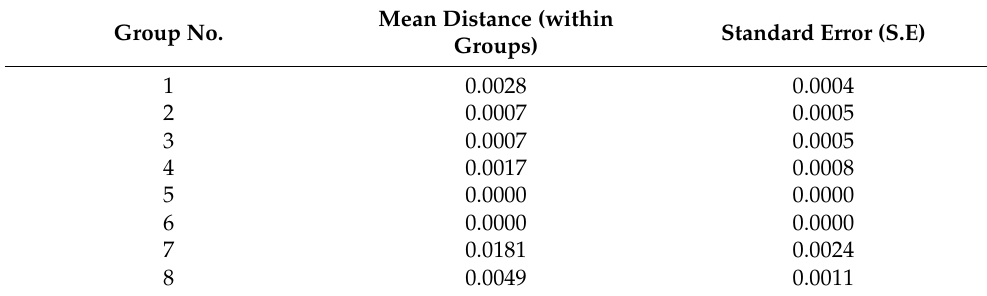
Table 2. Estimates of the average evolutionary divergence over sequence pairs within groups based on MLST analysis. Group No.